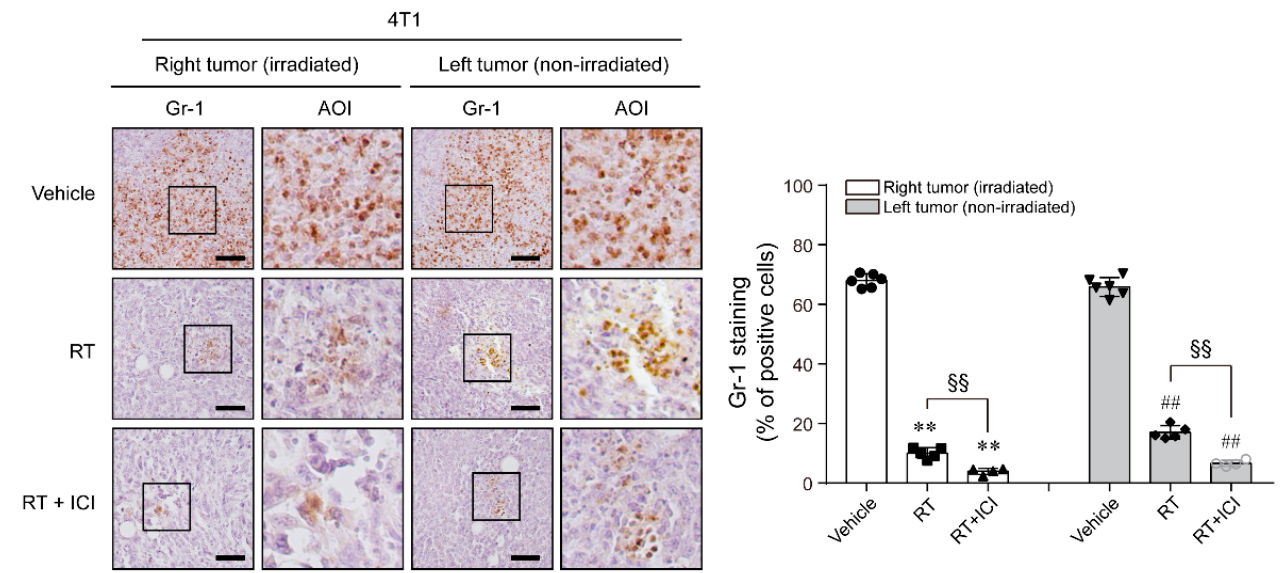
Figure 3. Combined PD-1 blockade therapy and RT regulated the infiltration of MDSCs, showing an abscopal effect. Six-week-old female balb/c nude mice injected with 4T1 cells were sacrificed on day 21 after injection (n = 4–6), and then tumor tissues were obtained and immunohistochemically stained with antibody for GR-1, an MDSC marker. GR-1-positive cells were identified by counting the number of cells stained intensely in fields from tumor tissues of each indicated group. ** p < 0.01 compared to the primary (R) tumor of vehicle-treated 4T1-injected group; ## p < 0.01 compared to the secondary (L) tumor of vehicle-treated 4T1-injected group; §§ p < 0.01; AOI, area of interest; scale bar: 100 µm.